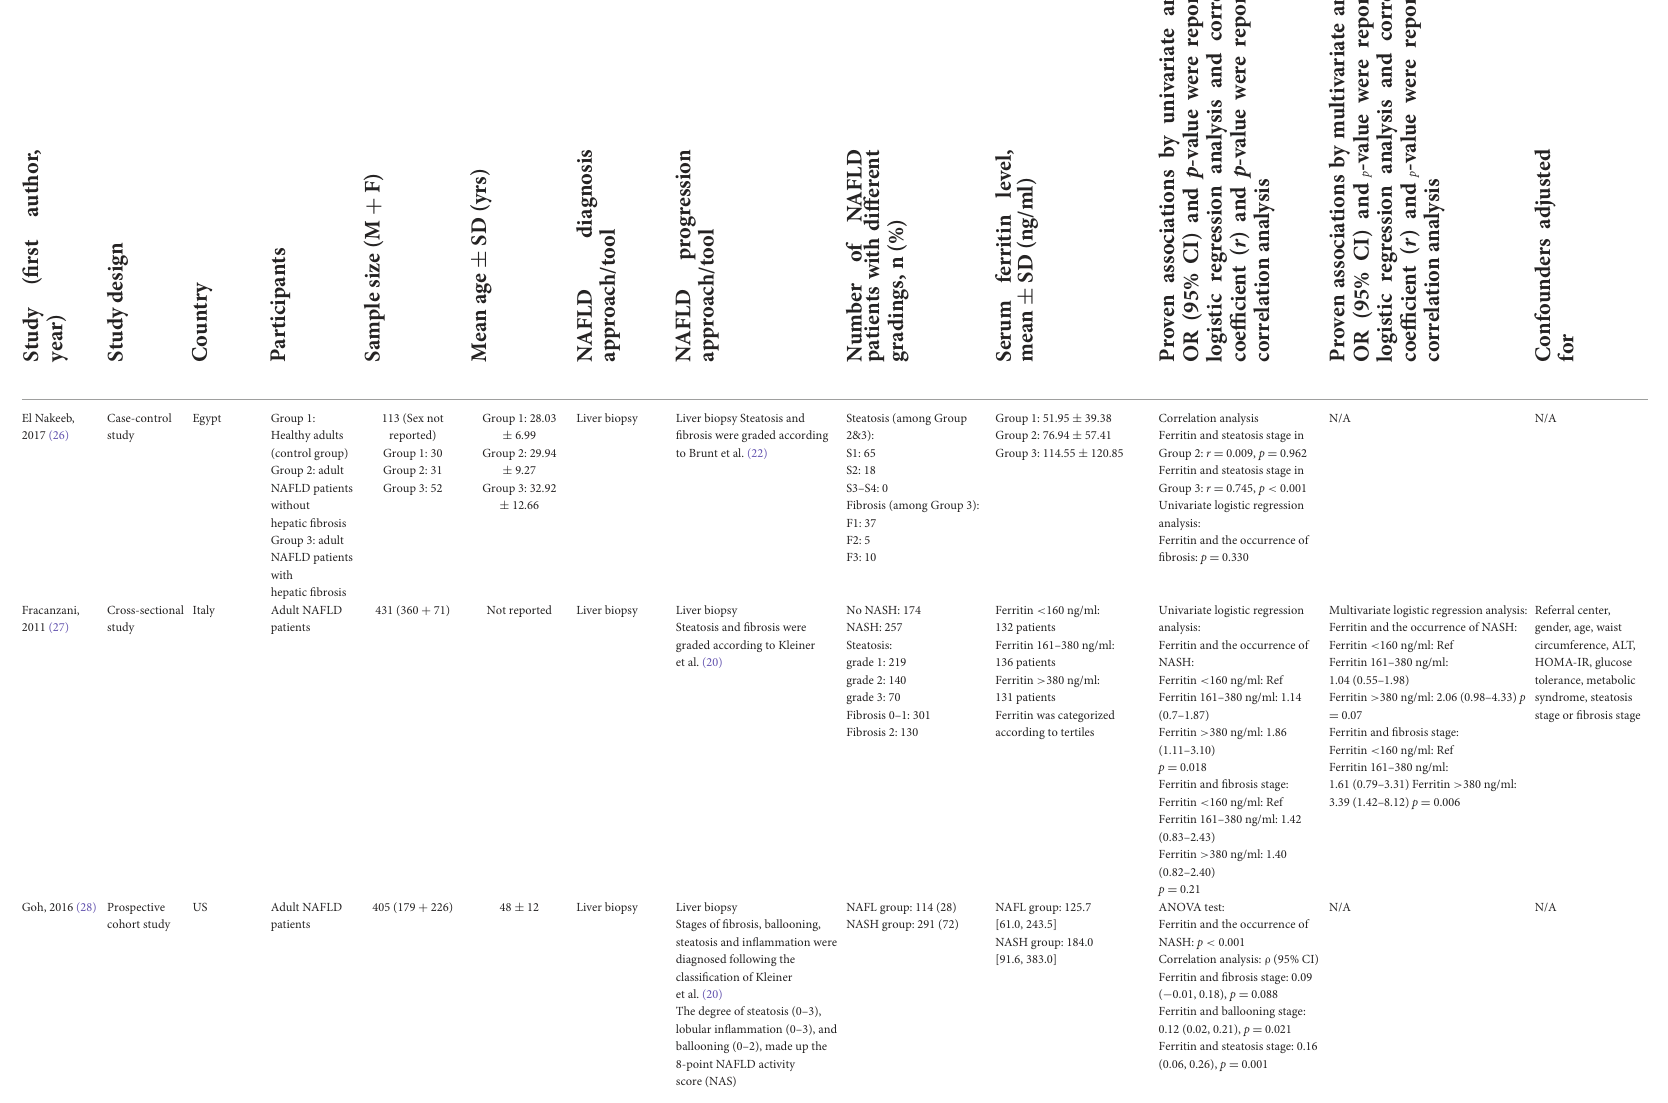
Liverbiopsy Liverbiopsy Stagesoffibrosis,ballooning, steatosisandinflammationwere diagnosedfollowingthe classificationofKleiner